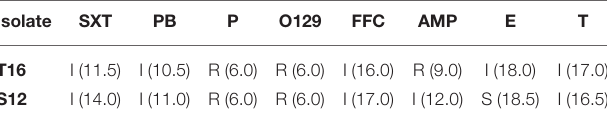
TABLE 3 | Antibiotic susceptibility results for two F. spartansii isolates as determined via the Kirby-Bauer disk diffusion method.